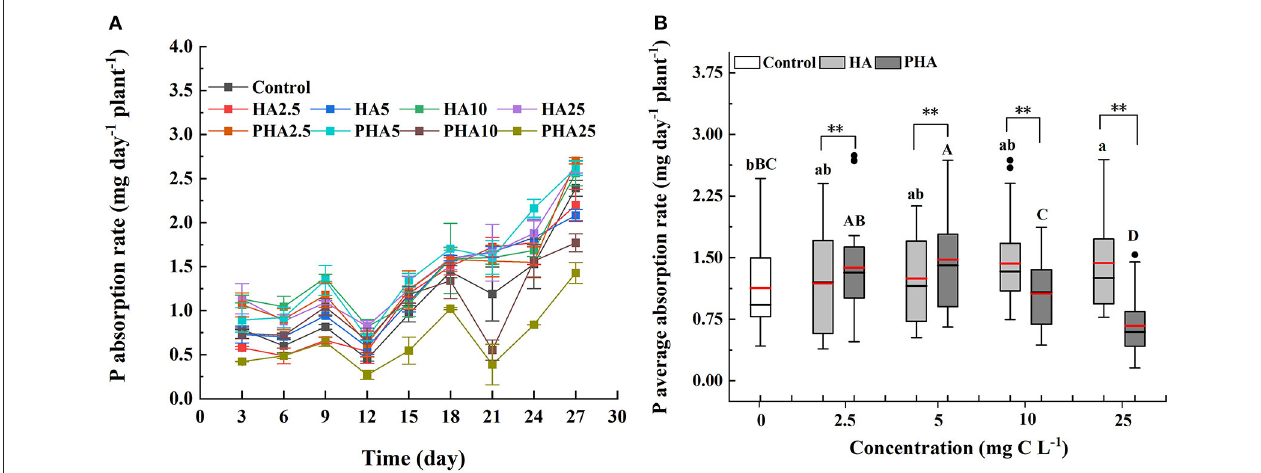
FIGURE 3 | Effects of 2.5–25mg C L − 1 of HA and PHA on (A) P absorption rate over time ( n = 3) and (B) average P absorption rate ( n = 27). (B) Black lines, median value; red lines, mean value; lower and upper edges of the boxes, 25th and 75th percentiles of all data; bars, 5th and 95th percentiles of all data; dots in outside the boxes, < 5th and > 95th percentiles of all data. Different lowercase letters above the column indicate significant differences between HA and control treatments, while different capital letters above the column indicate significant differences between PHA and control treatments at P < 0.05, as determined by the LSD test. Significant differences between HA and PHA treatments at equivalent carbon concentrations were compared with two independent sample t -tests, ** P < 0.01.